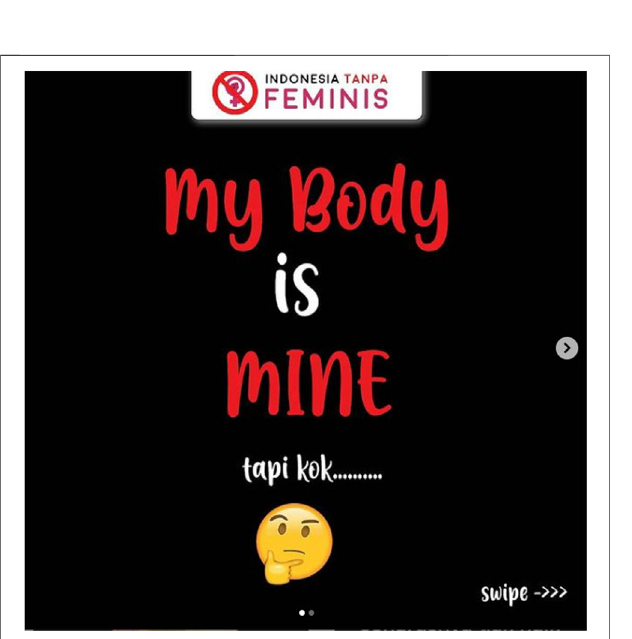
FIGURE 3 | The issue of feminist hatred toward men (Posted by @indonesiatanpafeminis.id on July 29, 2020).